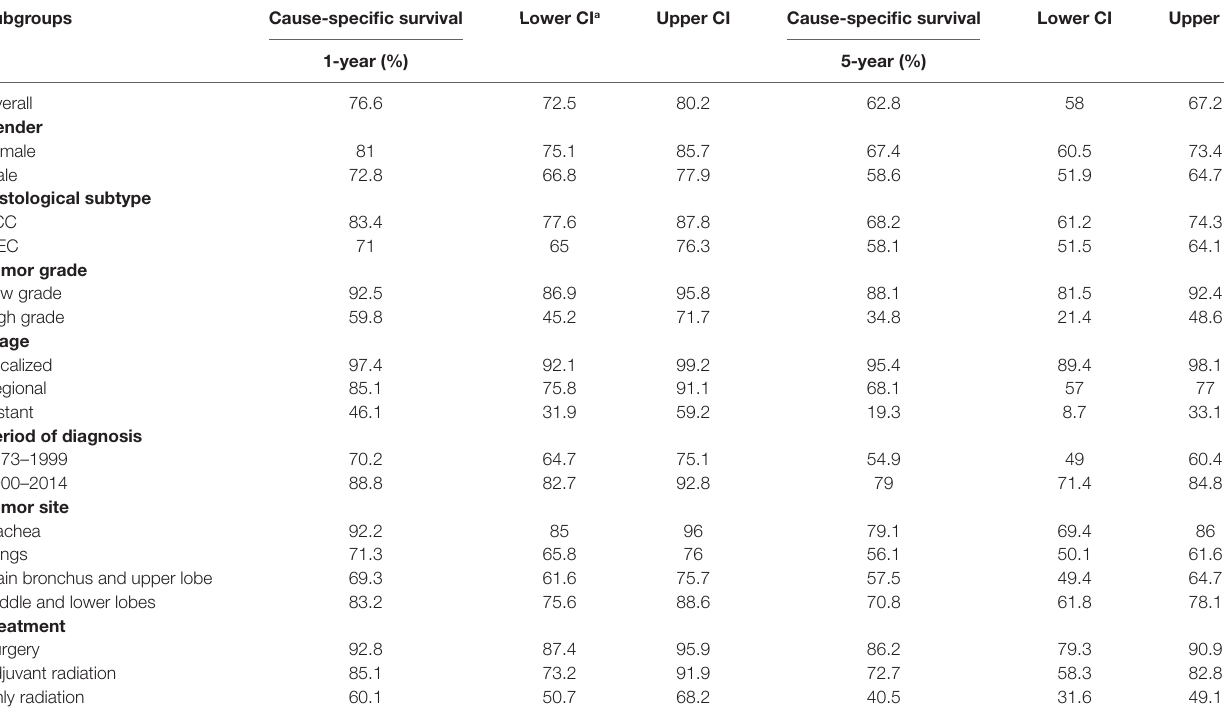
TaBle 2 | 1- and 5-year cause-specific survival in selected subgroups of patients with primary adenoid cystic carcinoma (ACC) and mucoepidermoid carcinoma (MEC) of lung. subgroups cause-specific survival lower ci a Upper ci cause-specific survival lower ci Upper ci 1-year (%) 5-year (%) Overall 76.6